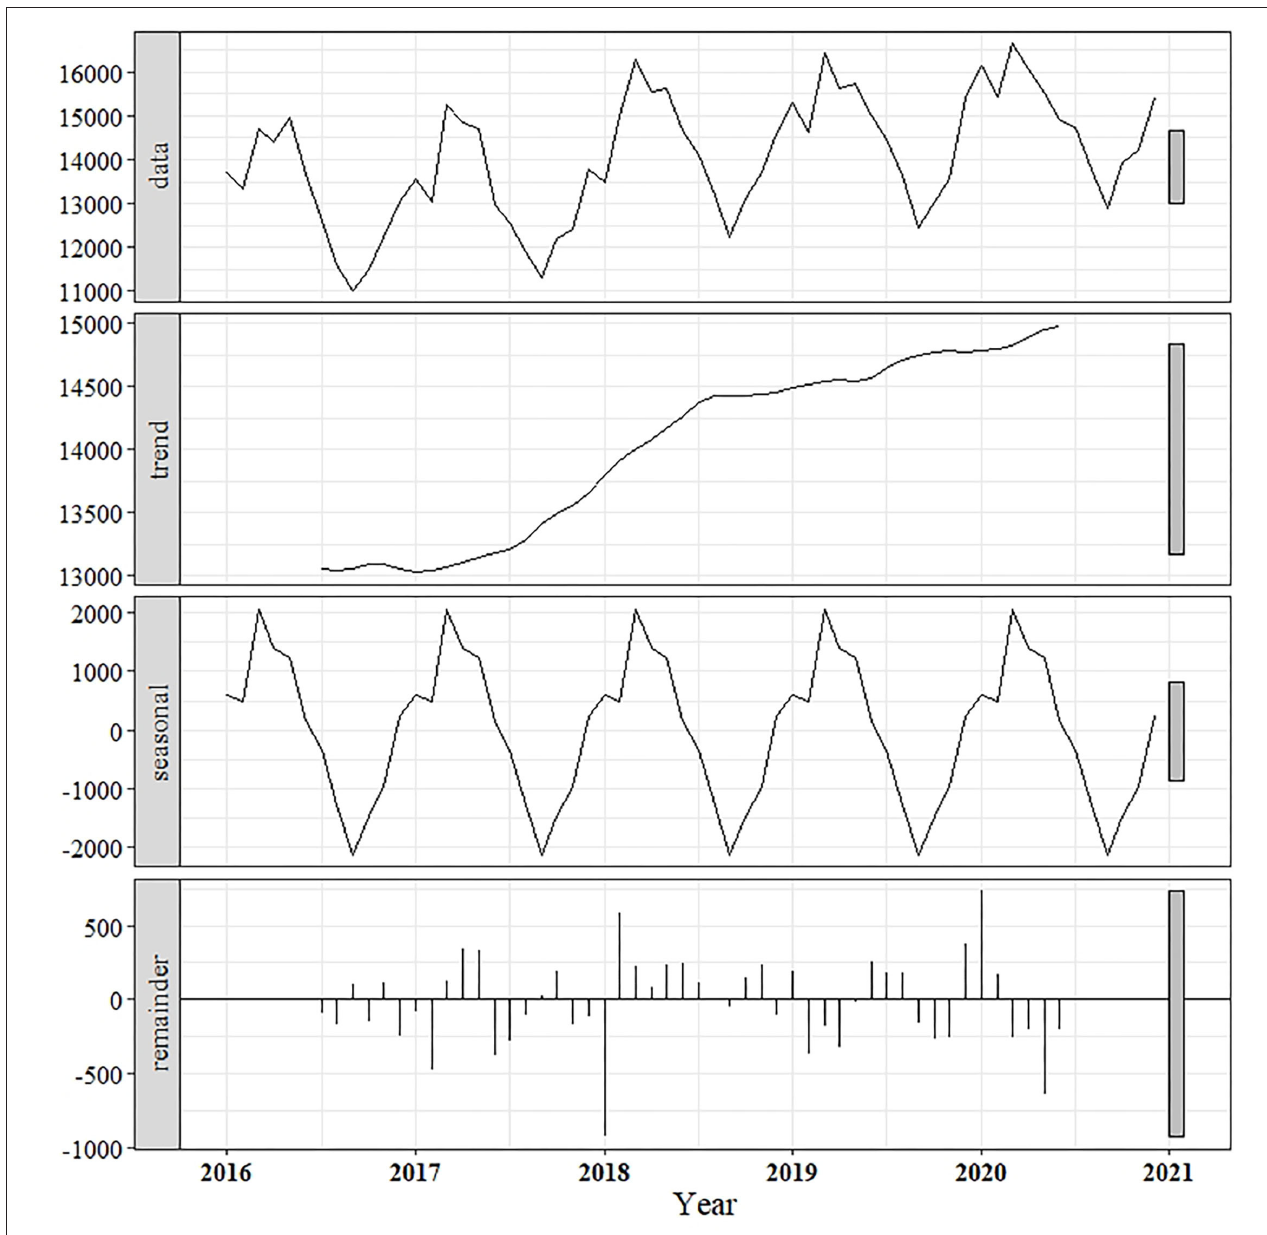
datasets. Thus, we forecasted milk production for the periods using training and full datasets, respectively. The performance of forecast models was determined by comparing the milk production forecast values from forecast models applied to the training dataset with actual milk production values from the validation dataset. In addition, forecast values for milk production for the period of January 2021-December 2022 were computed using forecast models applied to the full